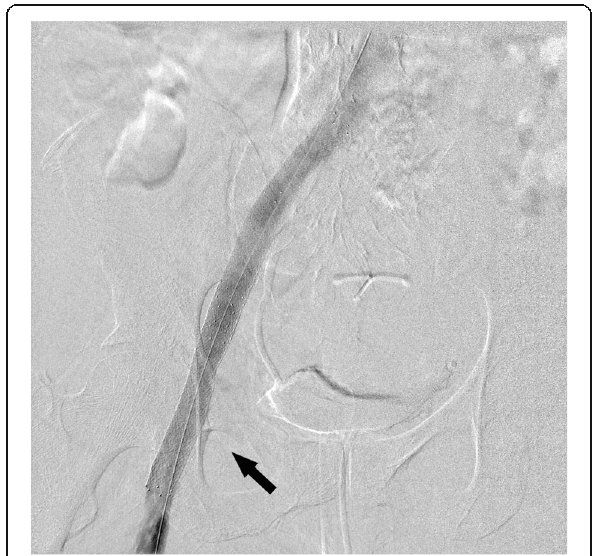
Fig. 6 Post stent venography. Brisky flow is demonstrated through the stented iliac vein (black arrow). Drainage through lumbar and sapheno-saphenous collaterals are no longer